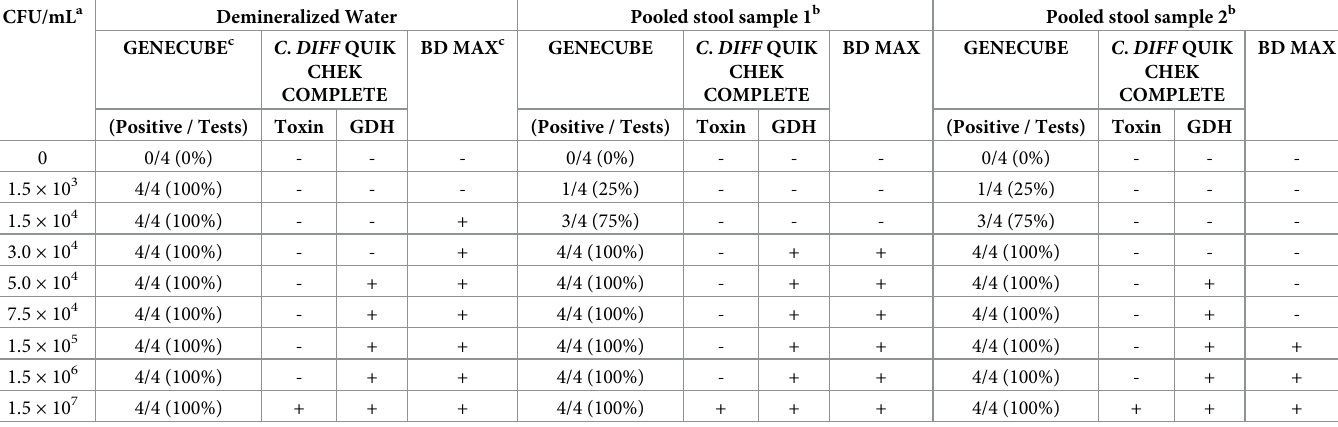
Table 2. Investigation of the limit of detection of the GENECUBE Clostridioides difficile assay compared with other assays.